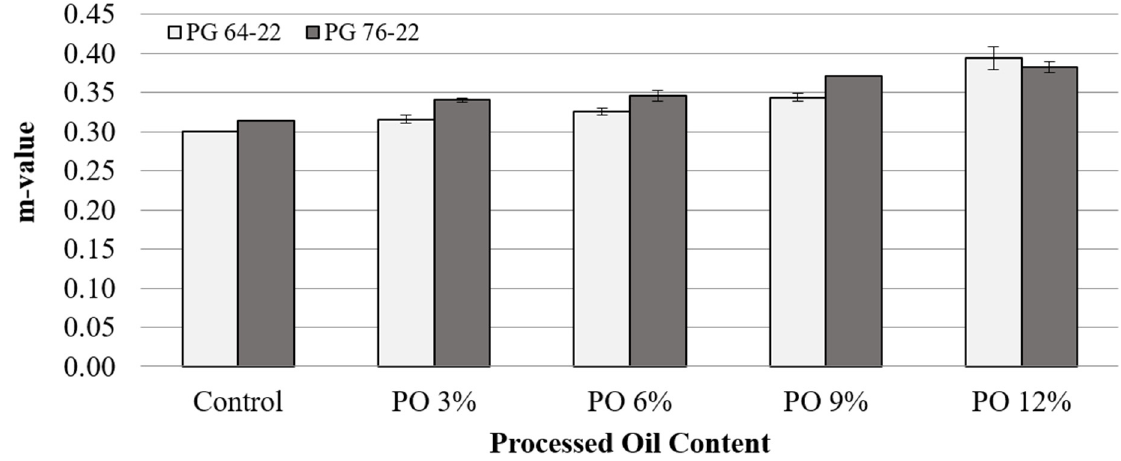
Figure 10. m ‐ value of asphalt binder with processed oil at − 12 °C. Figure 10. m-value of asphalt binder with processed oil at − 12 ◦